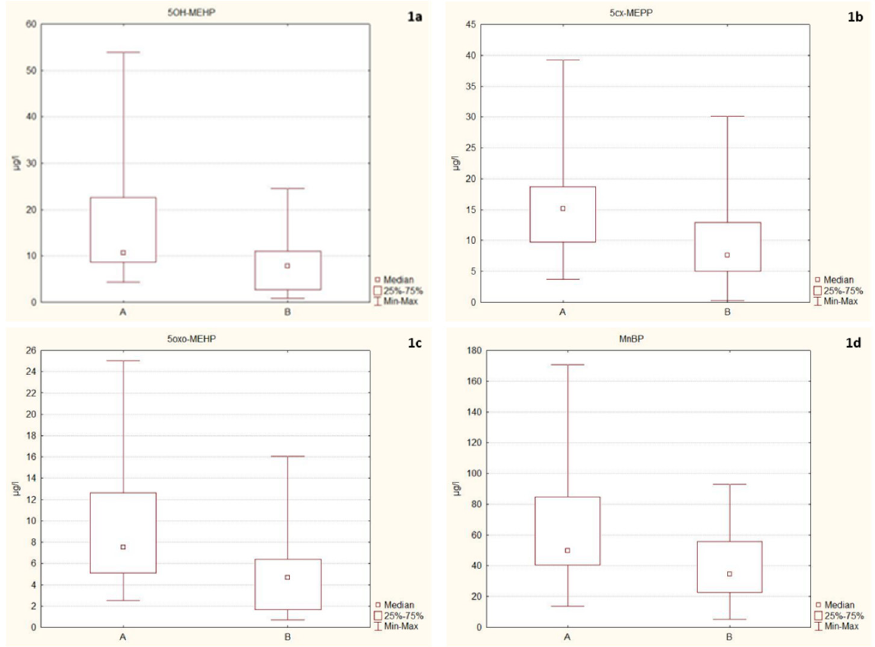
Figure 1. ( a – d ) Box and whisker plots of urinary concentrations of phthalate metabolites: A —Consumption of food heated in a plastic container; B —Nonconsumption of food heated in a plastic container; 5OH-MEHP, mono(2-ethyl-5-hydroxyhexyl) phthalate, p = 0.04; 5cx-MECPP, mono(2-ethyl-5-carboxypentyl) phthalate, p = 0.03; 5oxo-MEHP, mono(2-ethyl-5-oxohexyl) phthalate, p = 0.02; MnBP, Mono-n-butyl phthalate, p = 0.03.